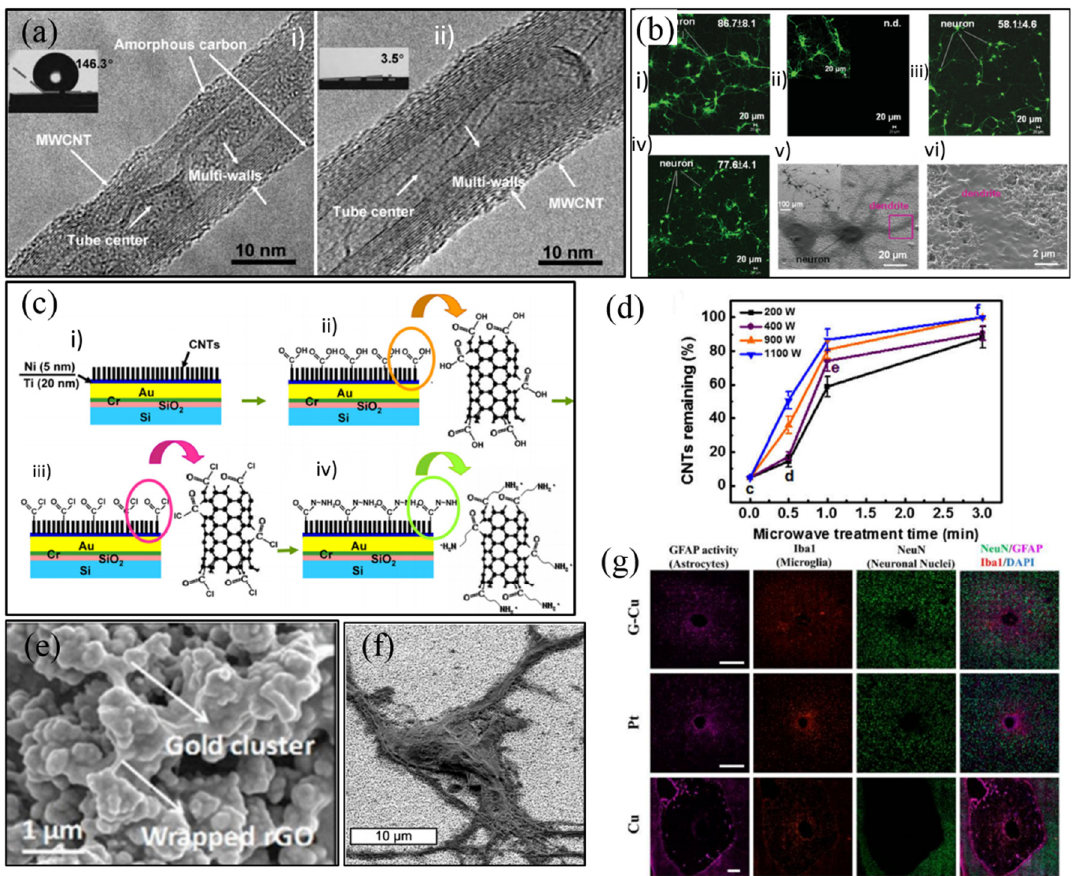
Figure 11. ( a ) Transmission electron microscope (TEM) of multi-walled carbon nanotube (MWCNT) with amorphous carbon before and after plasma treatment [115] ; ( b ) fluorescent images of neuron cells cultured on as-grown carbon nanotubes (CNTs) and UV-ozone-modified CNTs, and corresponding SEM images [117] ; ( c ) Process flow of MWCNT amino-functionalization [118] ; ( d ) the percentages of CNTs remaining after 5 min sonication vs. microwave treatment time at various powers [123] ; ( e ) SEM image of reduced graphene oxide (GO) coating [124] ; ( f ) SEM images of neural cells attached well to GO coating [125] ; ( g ) histological studies of tissue response to GO coating [122] . Reproduced from the mentioned references with permission from the related journals.